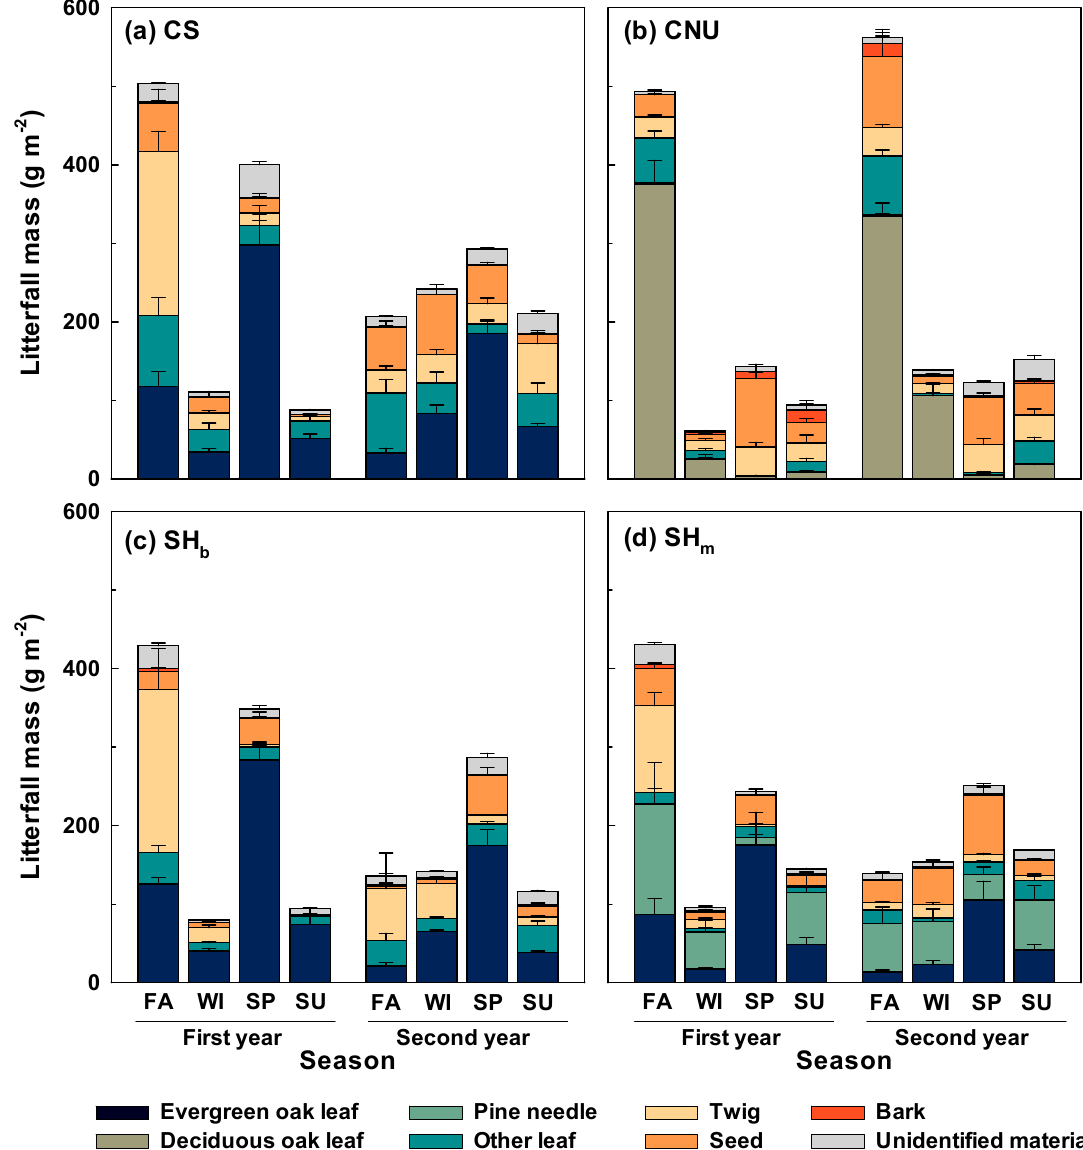
Figure 3. Seasonal variation of litterfall mass in (a) evergreen broadleaved forest at Cheongsu (CS), (b) deciduous broadleaved forest at Chungnam National University (CNU), (c) evergreen broadleaved forest at Seonheul (SH b ), and (d) mixed forest at Seonheul (SH m ) from August 2016 to August 2018. FA, WI, SP, and SU indicate the seasons of fall, winter, spring, and summer, respectively. First and second year indicate the period from August 19, 2016 to August 23, 2017 and from August 24, 2017 to August 21, 2018, respectively. Evergreen oak leaf includes Quercus glauca and Q. salicina in CS, SH b , and SH m . Pine needle in SH m represents needle litter of Pinus thunbergii . Deciduous oak leaf in CNU represents leaf litter of Q. acutissima .